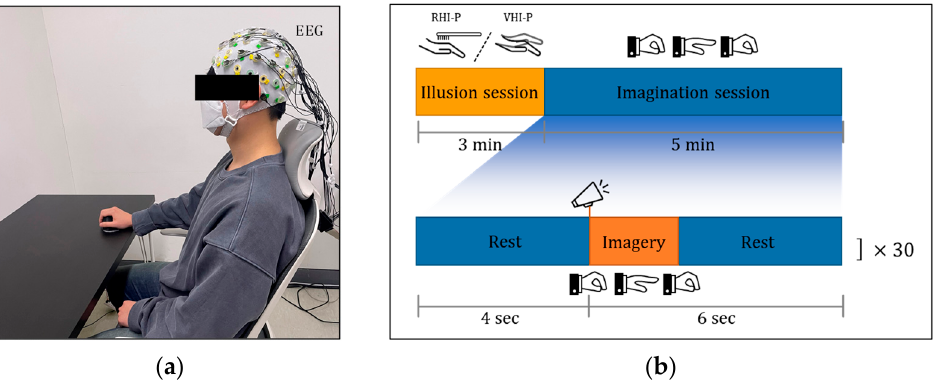
Figure 2. Experimental protocol: ( a ) Setup of pure motor imagery (MI-P) and pure motor execution (ME-P); ( b ) trial design. The upper blocks indicate the protocol for the illusion-based MI guidance system. Each illusion session for VHI-P and RHI-P lasted 3 min, and the imagination session was followed for 5 min. The lower blocks indicate the protocol for MI-P and the imagination session of the illusion-based MI guidance system. In the session, imagery task was performed whenever an auditory cue that was repeated in every 10 s was provided.